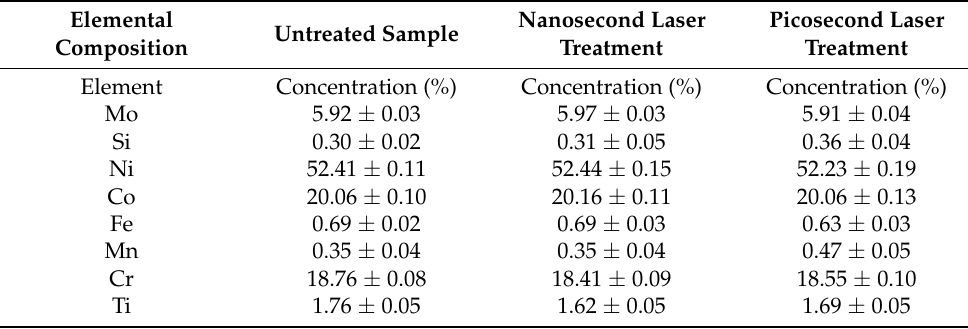
Table 3. Results of the X-ray fluorescence XRF qualitative and quantitative analysis.